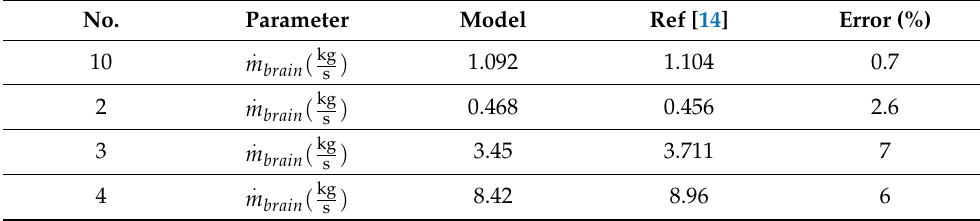
Figure 3. Comparison of the net output power in the present work with that in [14] versus the evaporator temperature of the ORC. Table 11. Validation results of the RO